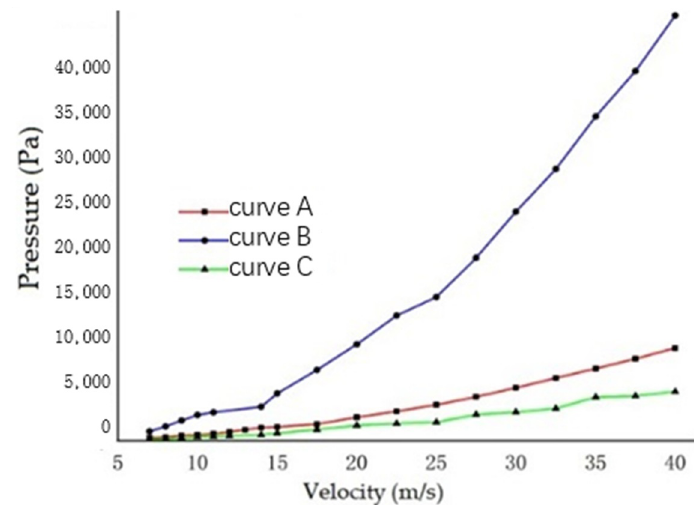
Figure 4. Velocity–pressure curves.